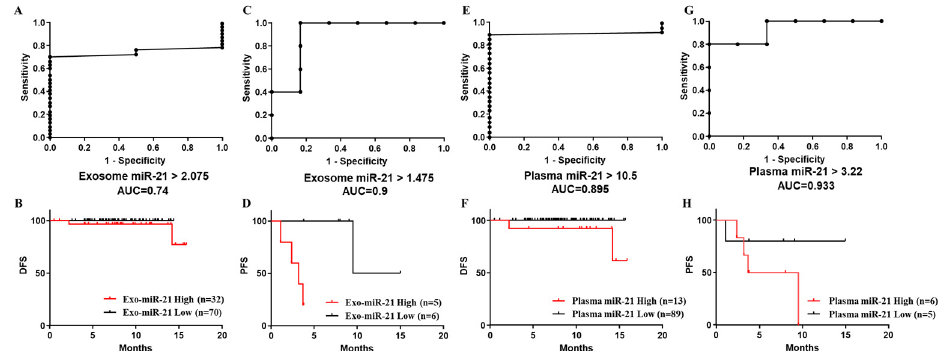
Figure 4. Receiver Operating Characteristics (ROC) curve and Kaplan–Meier survival analyses of